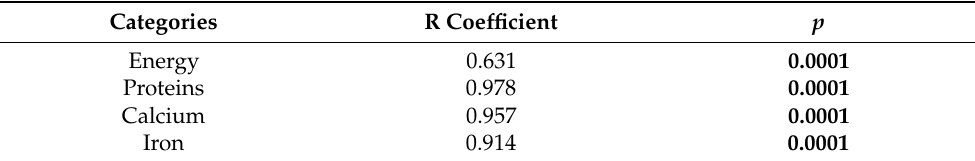
Table 5. Pearson correlation coefficient between Nutrilog© and Nutricate© (n =